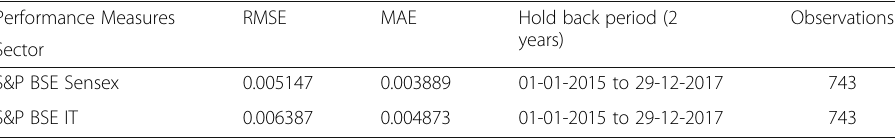
Table 6 Forecasting evaluation results